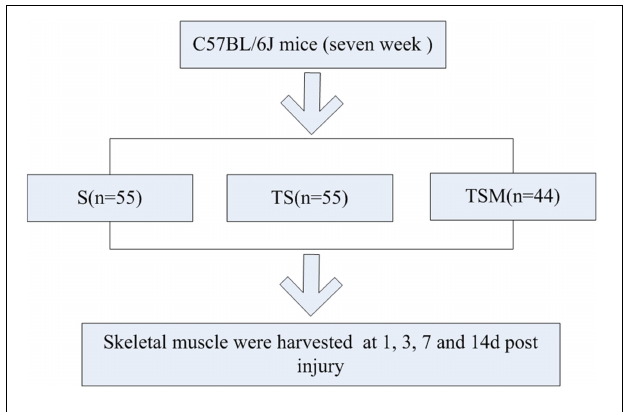
FIGURE 1 | Experimental schedule. S group, skeletal muscle contusion group; TS group, skeletal muscle contusion and macrophage depletion group; TSM group, muscle contusion, macrophage depletion, and MGF treated group.